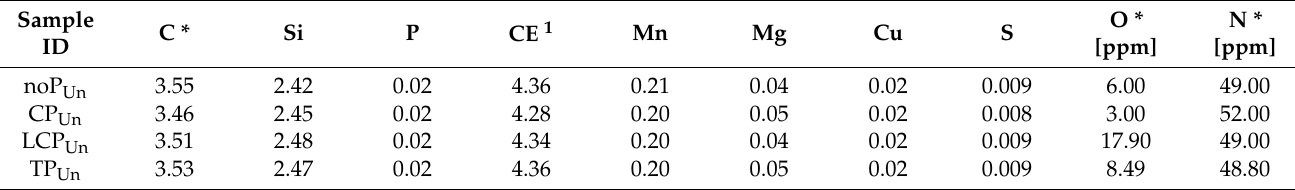
Table 3. Chemical composition (wt.%) of the